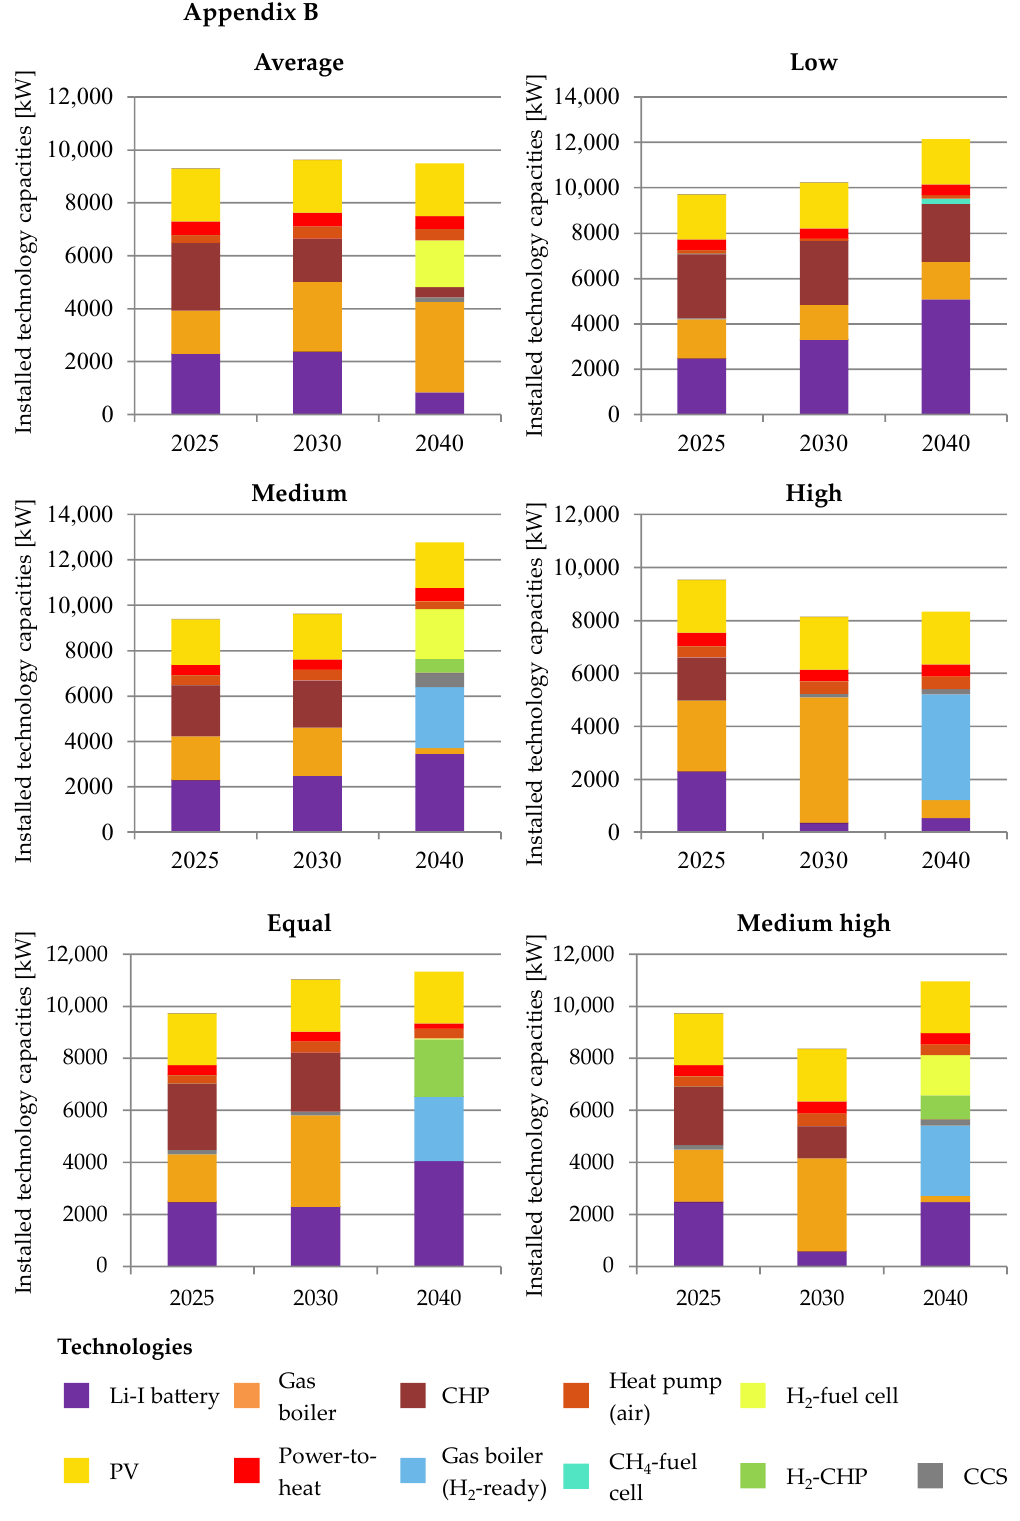
Figure A2. Installed technologies for different myopic scenarios with uncertain CO 2 prices and energy carrier costs (myopic, with CCS).